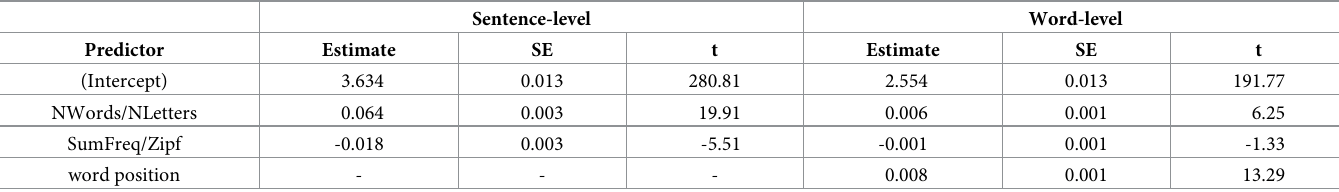
Table 3. Results of the mixed-effects model with only control